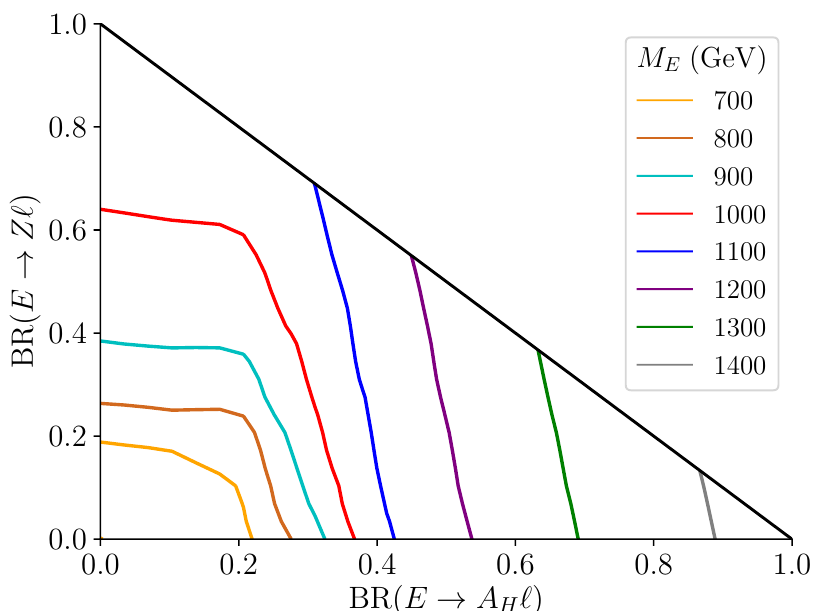
Figure 10 . Projected limits on the mass of the VLL, M E for arbitrary branching fractions for the HL-LHC. (See text and figure 9 for